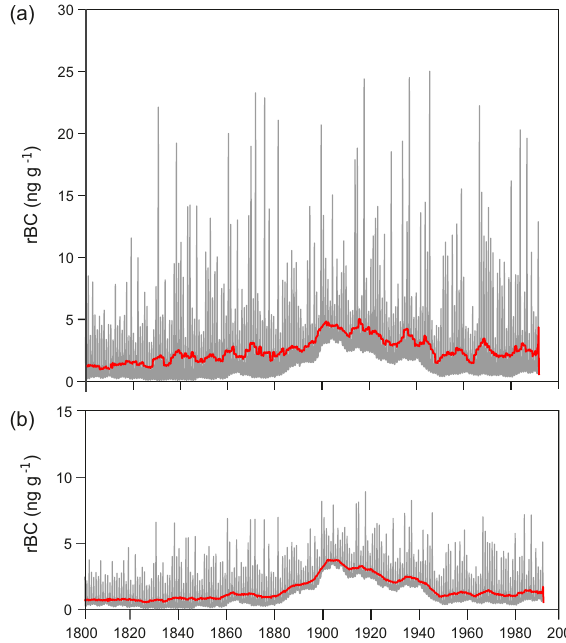
Figure 7. Simulation of the effects of wind scouring of snow on the preservation of an anthropogenic signal of rBC deposition in a synthetic ice-core times series of rBC spanning the period from 1800 to 1990. (a) The synthetic series, with a pseudo-seasonal cy- cle superimposed on the interdecadal baseline trend observed in the Greenland D4 record (McConnell et al., 2007). (b) The synthetic series after randomly truncating the amplitude of all winter deposi- tion peaks (November–March) by 30%–60%. The bold red line in both panels is a 5-year running geometric